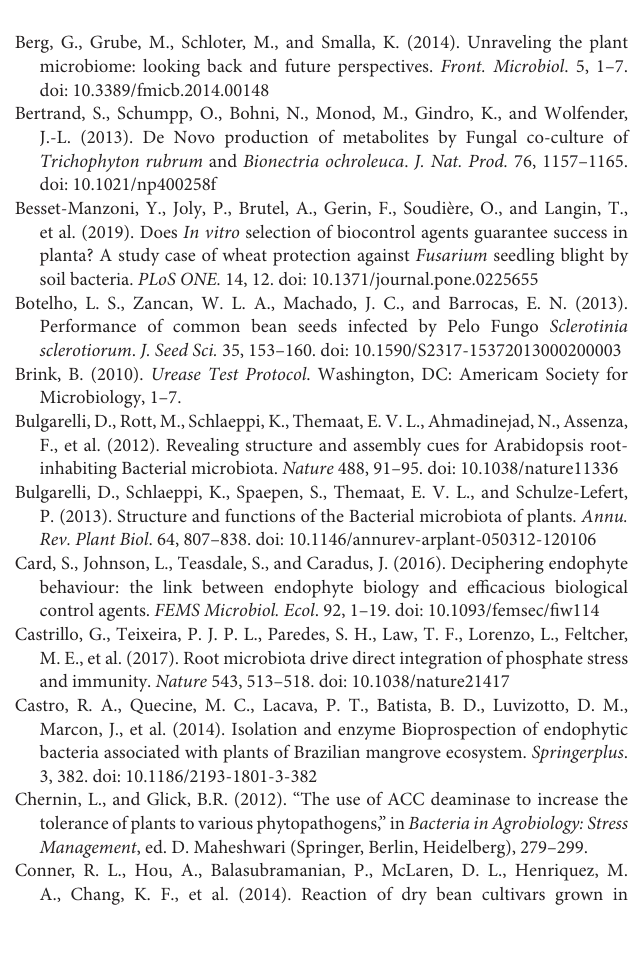
Supplementary Figure 1 | IAA production by bacterial endophytes. Supplementary Table 1 | List of endophytic bacteria isolated in this study and closest relatives in gene